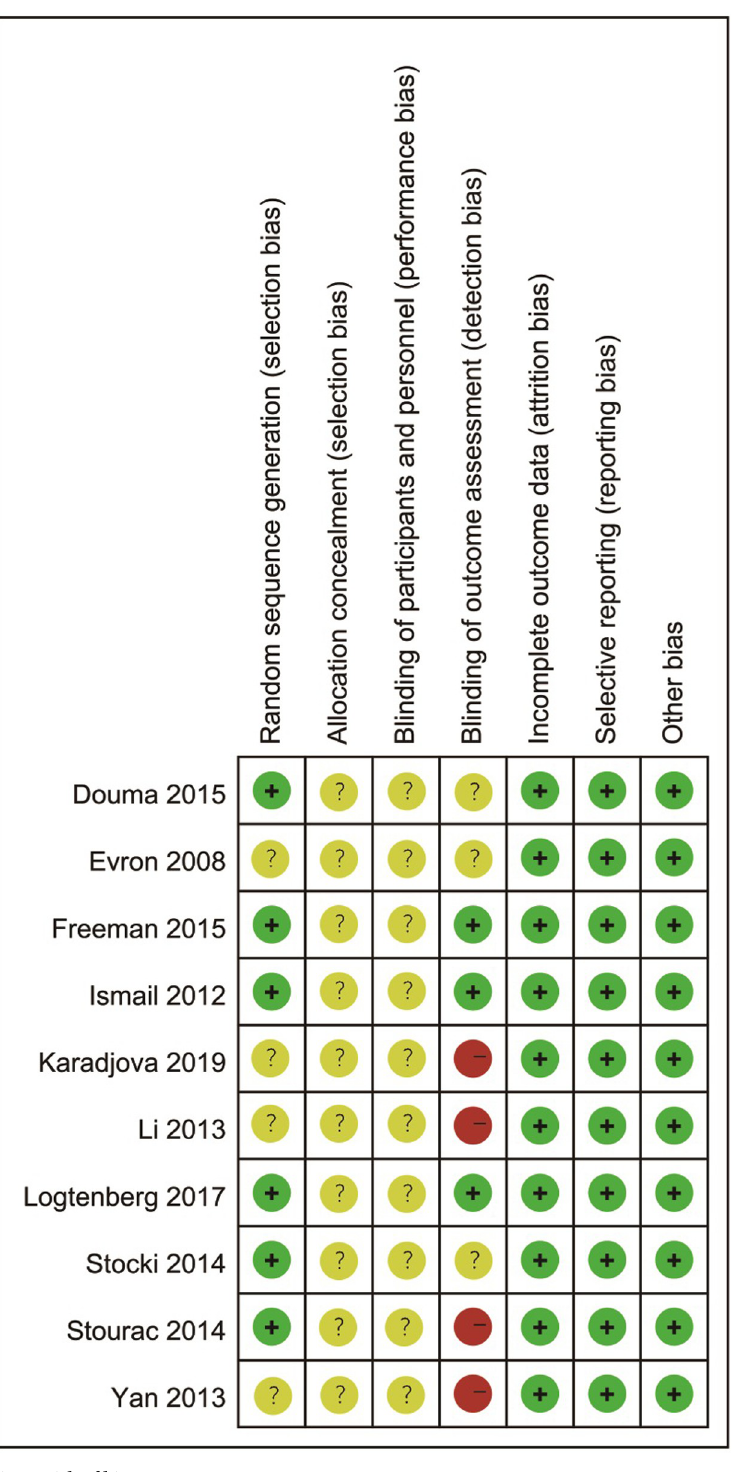
Fig 3. Risk of bias